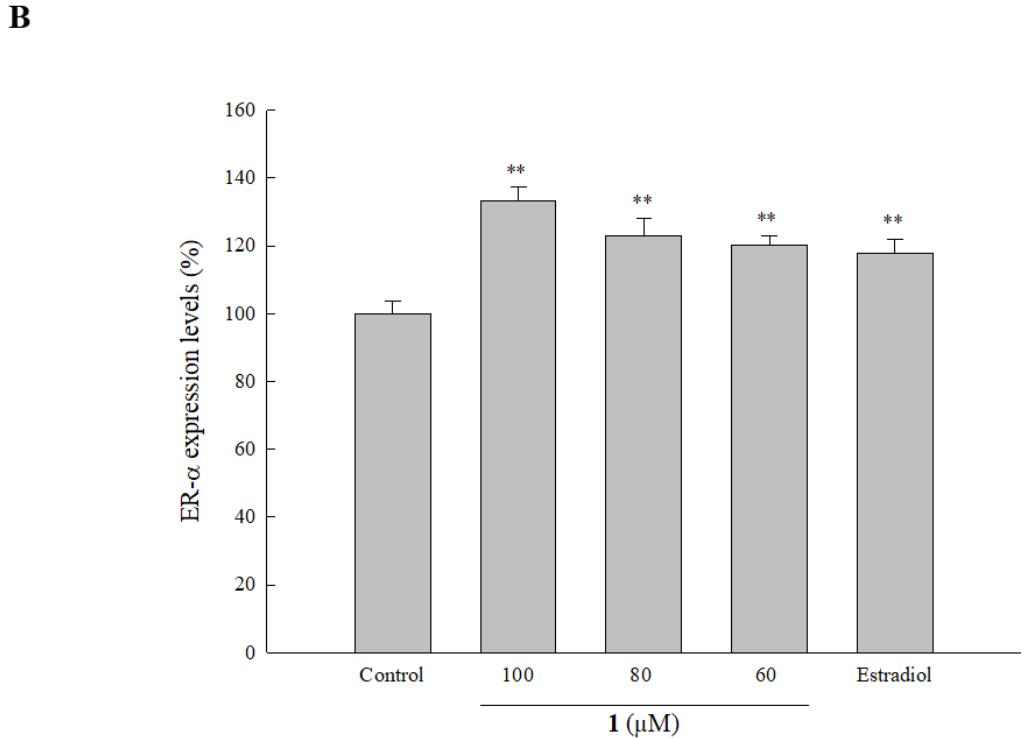
Figure 4. Effect of isolated compounds on ER expression in HOb cells. Cells were seeded in a 96-well plate and after 24 h, 100 µM of samples and 1 µM estradiol (positive control) were added. After five days, ( A ) ER-α/β expression levels were detected. ( B ) The dose-dependent effect of 1 on the expression of ER-α was analyzed. Data are expressed as the mean ± SD (** p ≤ 0.01 compared to the control), and all experiments were performed in triplicate.